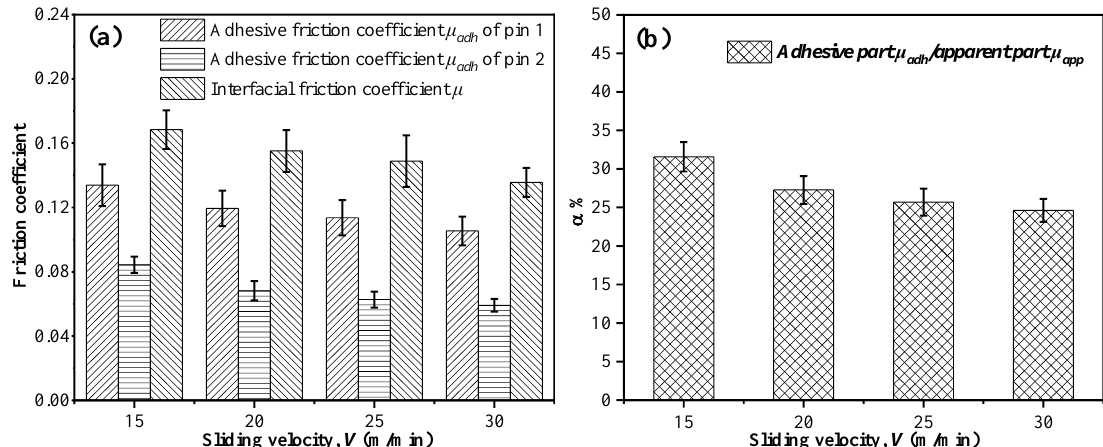
Figure 7. ( a ) The adhesive friction coefficients, the interfacial friction coefficients of the two pins and ( b ) the µ adh / µ app vs. the sliding velocity.